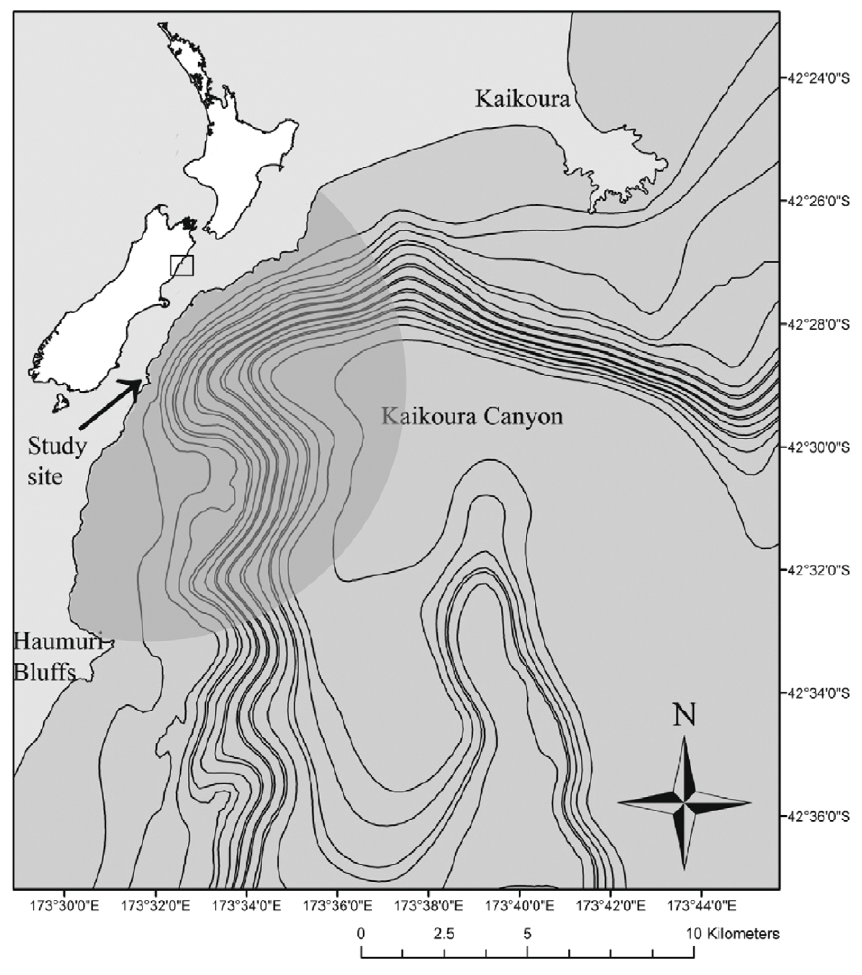
Figure 1. Study area from Kaikoura Peninsula to Haumuri Bluffs. Lines are 100 m depth contours. Location of theodolite station used to collect data indicated with arrow. Gray semi-circle indicates approximate observation area.